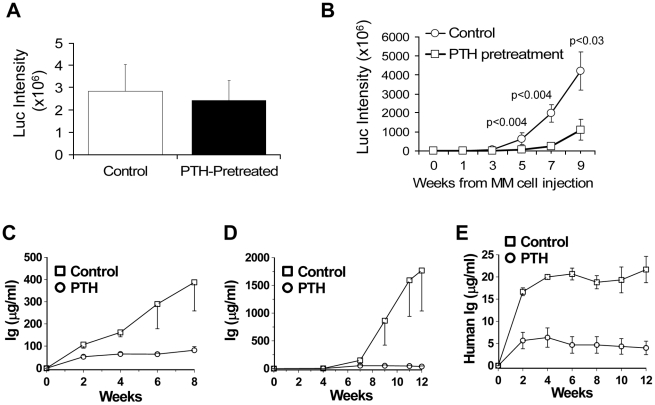
PTH pretreatment inhibits myeloma progression.SCID-rab mice were pretreated with PTH for 4 weeks and then injected with BN stroma-dependent myeloma cells (six mice/group) or with myeloma cells from one of three patients (for each patient's cells, a total of six hosts were used: three pretreated with saline, three pretreated with PTH). Treatment with PTH continued throughout the experimental period (see schema of the experimental design in Figure 4A). (A) In vivo live-animal imaging revealed similar luciferase (Luc) activity in BN myeloma cells a few hours after injection into saline- and PTH-pretreated hosts, indicating that similar numbers of myeloma cells were injected into the implanted bones in both groups. (B) Pretreatment with PTH inhibited growth of BN myeloma cells in SCID-rab mice. (C–E) Pretreatment with PTH delayed growth of primary myeloma cells from three different patients.